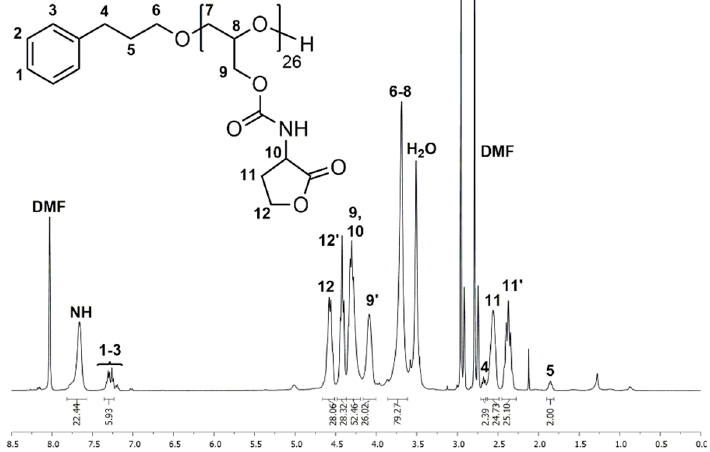
Figure 3. 1 H NMR spectrum of P(G HSL ) 26 ( 7 ) measured in DMF- d 7 .